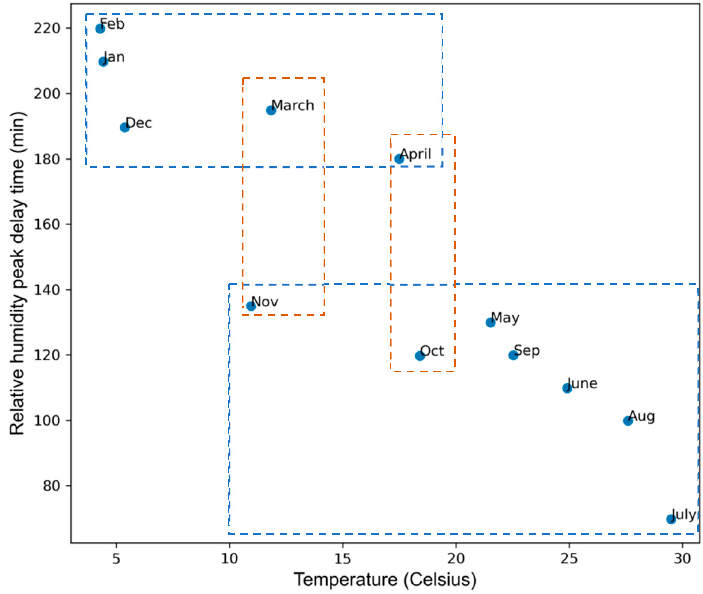
Figure 9. A scatter plot of monthly temperature and relative humidity peak delay time.